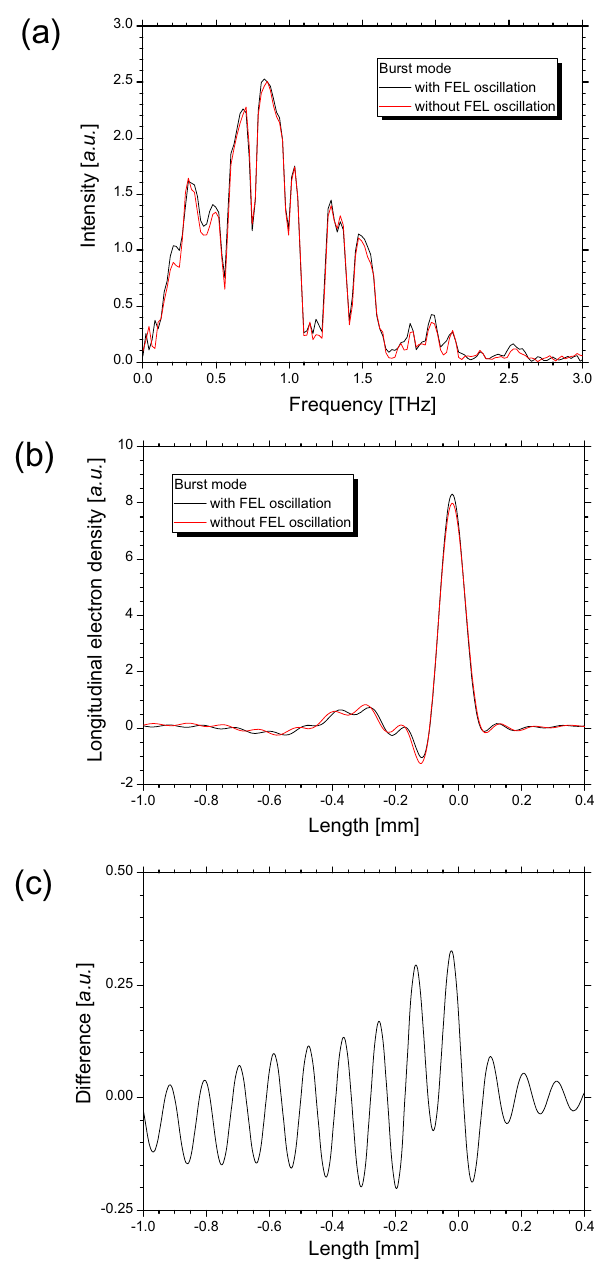
Figure 6. Observation of changes in CER spectrum and electron-bunch shape due to FEL oscillations at the electron energy of 75 MeV. In ( a ), spectrum of CER beam with (black line) and without (red line) FEL oscillations in burst mode. In ( b ), longitudinal electron-bunch shapes calculated by measured CER spectra with (black line) and without (red line) FEL oscillations. Electron densities were normalized such that the electron numbers were equal in both electron-bunch shapes. In ( c ), difference in normalized electron density with FEL oscillations minus normalized electron density without FEL oscillations in ( b